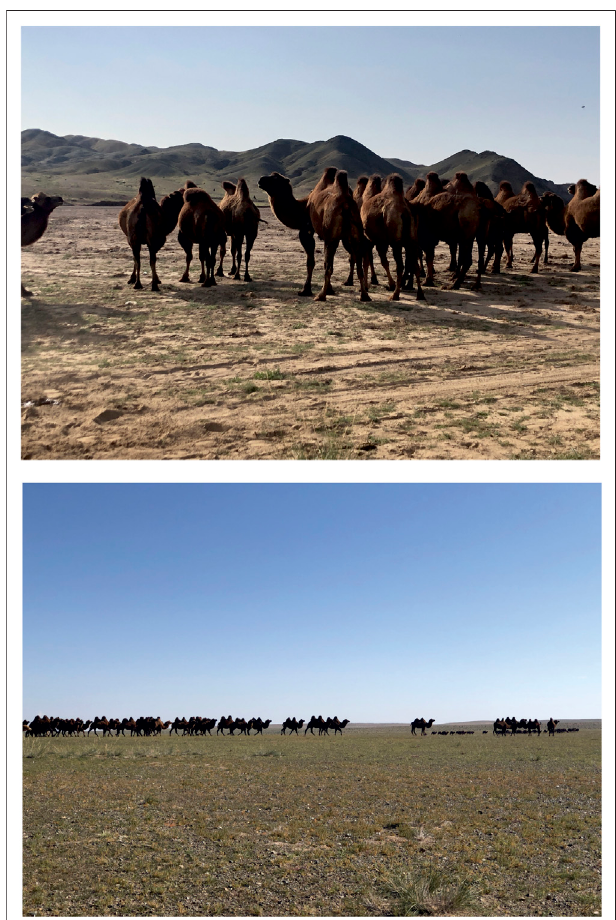
FIGURE 6| Herds ofmodern domesticated C. bactrianus near Tsagaan Agui Cave in the Gobi Altai Region and Holboljin Nuur Lake in the Valley of the Lakes Mongolia (photos by A. M. Khatsenovich, 2021).